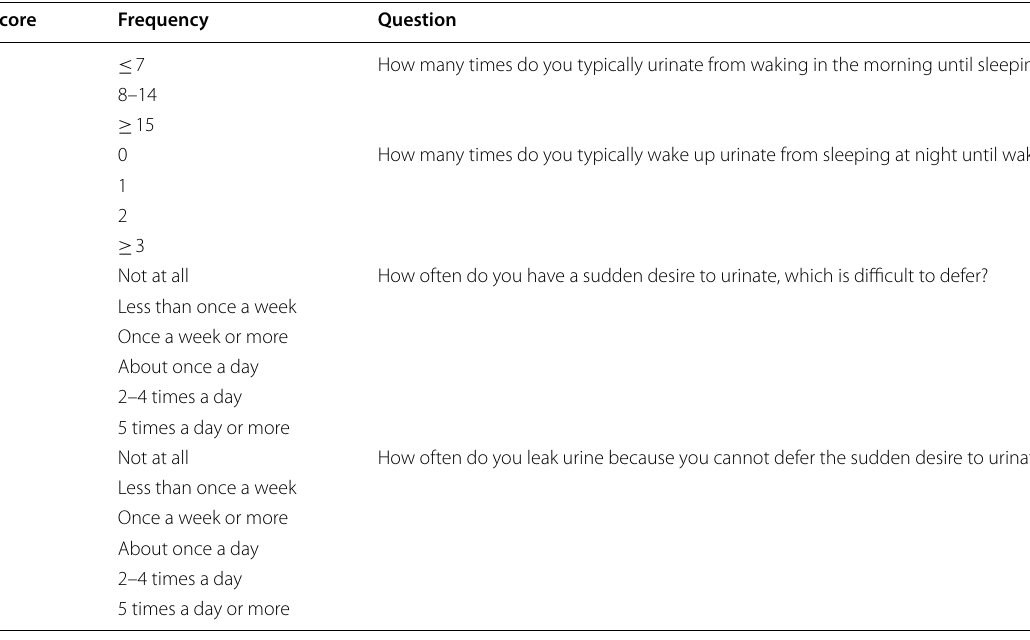
Table 2 Overactive bladder symptom score